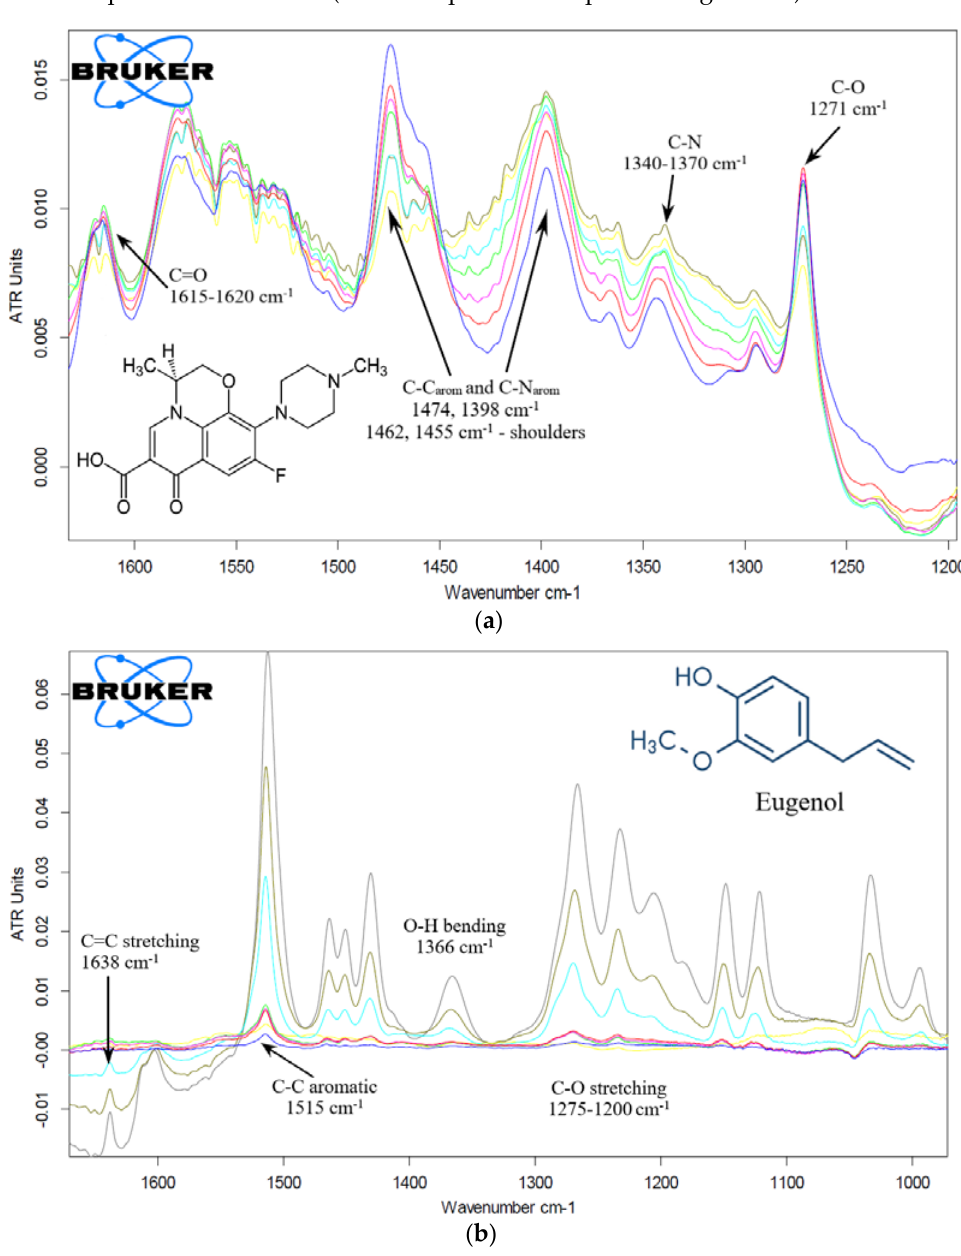
Figure 5. ( a ) Fourier transform infrared spectra of levofloxacin complexes with HPCD-spermine- Man- 1 . C 0 (Lev) = 5 mg/mL. 1 mM HCl solution. Molar ratio HPCD tori of ligand:Lev is 0, 0.06, 0.11, 0.23, 0.4, 0.6, 0.93 respectively for gradient spectra from blue to brown. ( b ) FTIR spectra of eugenol complexes with HPCD-PEI35-Man- 5 conjugate. C 0 (eugenol in water suspension) = 0.43 mg/mL. The concentration of the ligand per cyclodextrin tori ranged from 8 to 260 μ M. T = 22 °C.